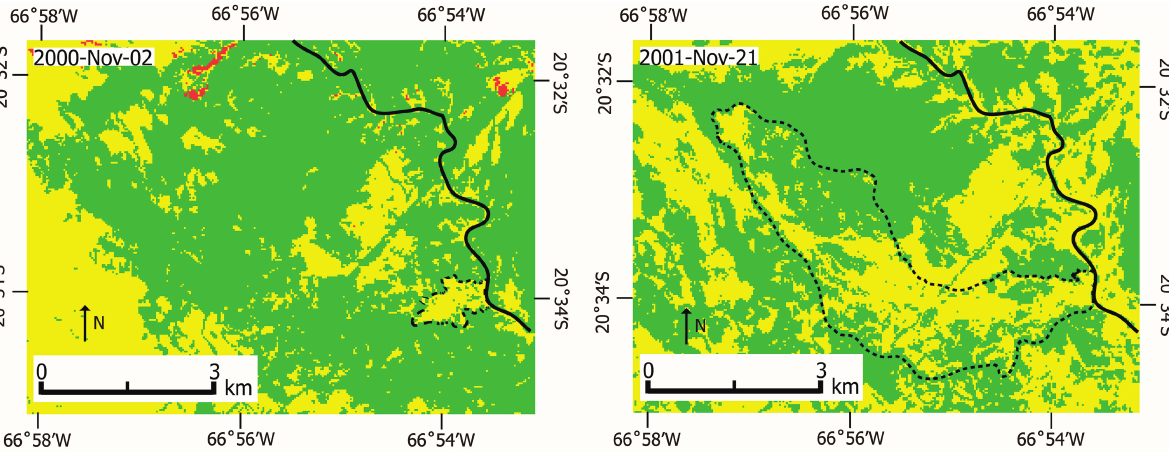
Figure 11. Reactivation of a crevasse splay. The bold black lines indicate the trunk channel while the dashed lines show the expanded splays. See Figure 1 for the location of the